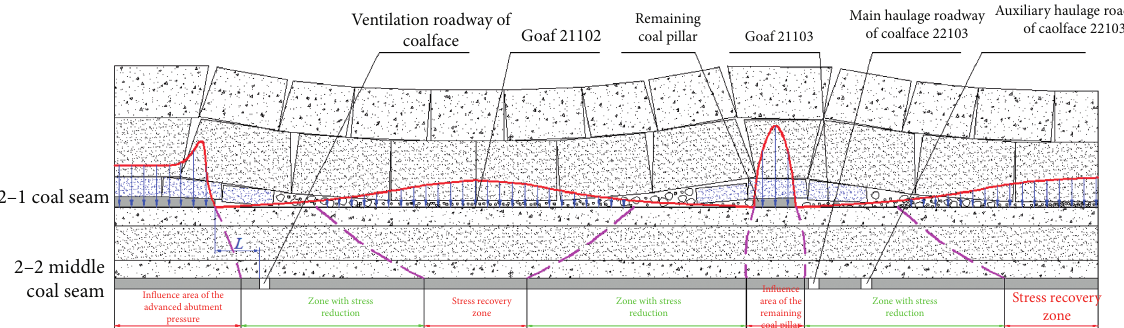
Figure 2: The model for the overburden strata and the stress distribution of coal after mining the upper protective